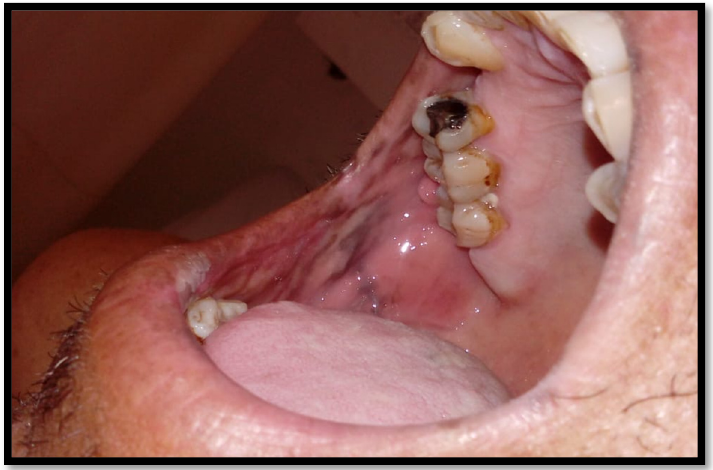
Figure 12. ( a ) Oral hyperpigmentation on the palate due to the use of the antiretroviral drug zidovudine; ( b ) Oral hyperpigmentation on the cheeks due to the use of the antiretroviral drug zidovudine.